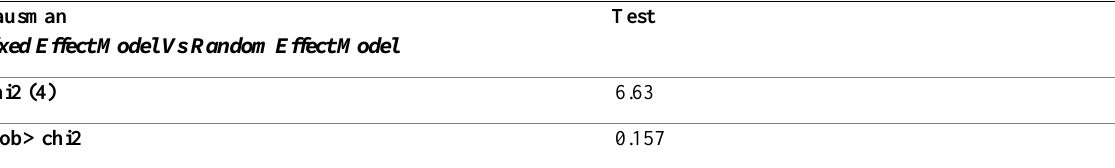
Table 3 : Hausman Test (Panel Data Model Selection)